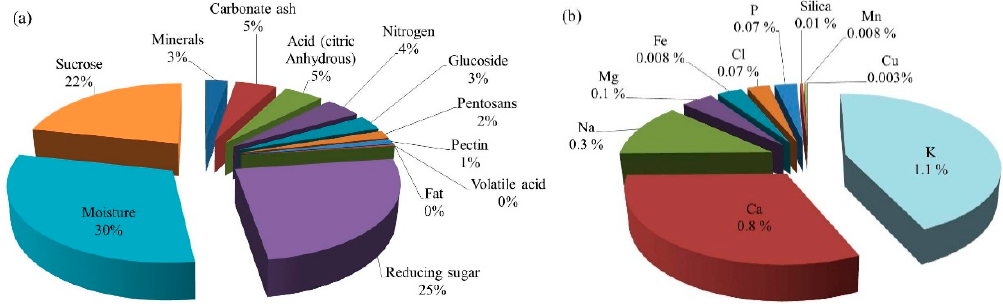
Figure 9. Stages of typical citrus waste processing to generate molasses [22].